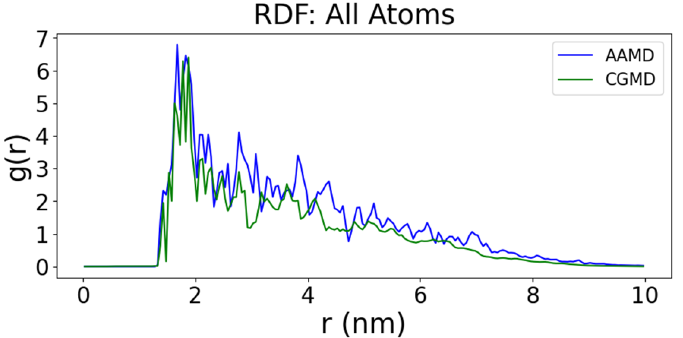
Figure 6. RDF plot of all atoms for comparison of CGMD vs. AAMD. Spearman’s correlation coefficient: 0.9692.